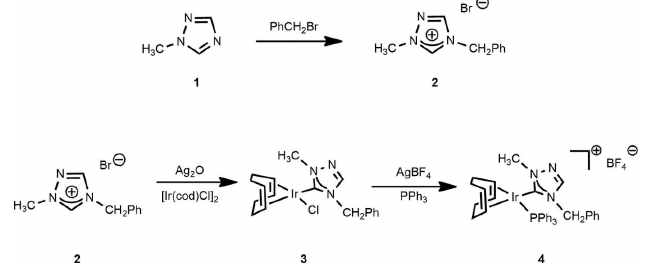
Figure 5 Reaction scheme showing the synthesis of the N-heterocyclic carbene ( 2 ) and the subsequent formation of the title ionic compound ( 4